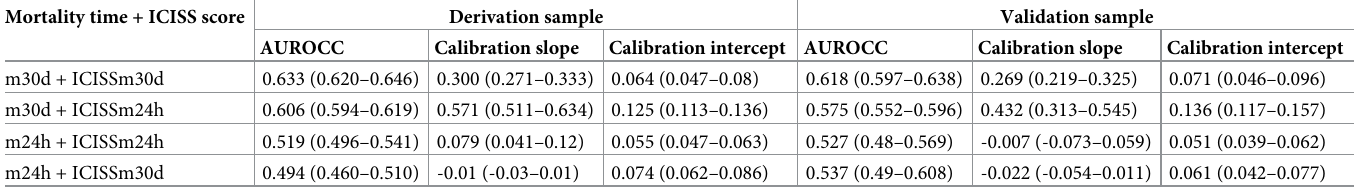
ICISS: International Classification of Disease Injury Severity Score, AUROCC: Area under the receiver operating characteristics curve, m30d: Mortality within 30